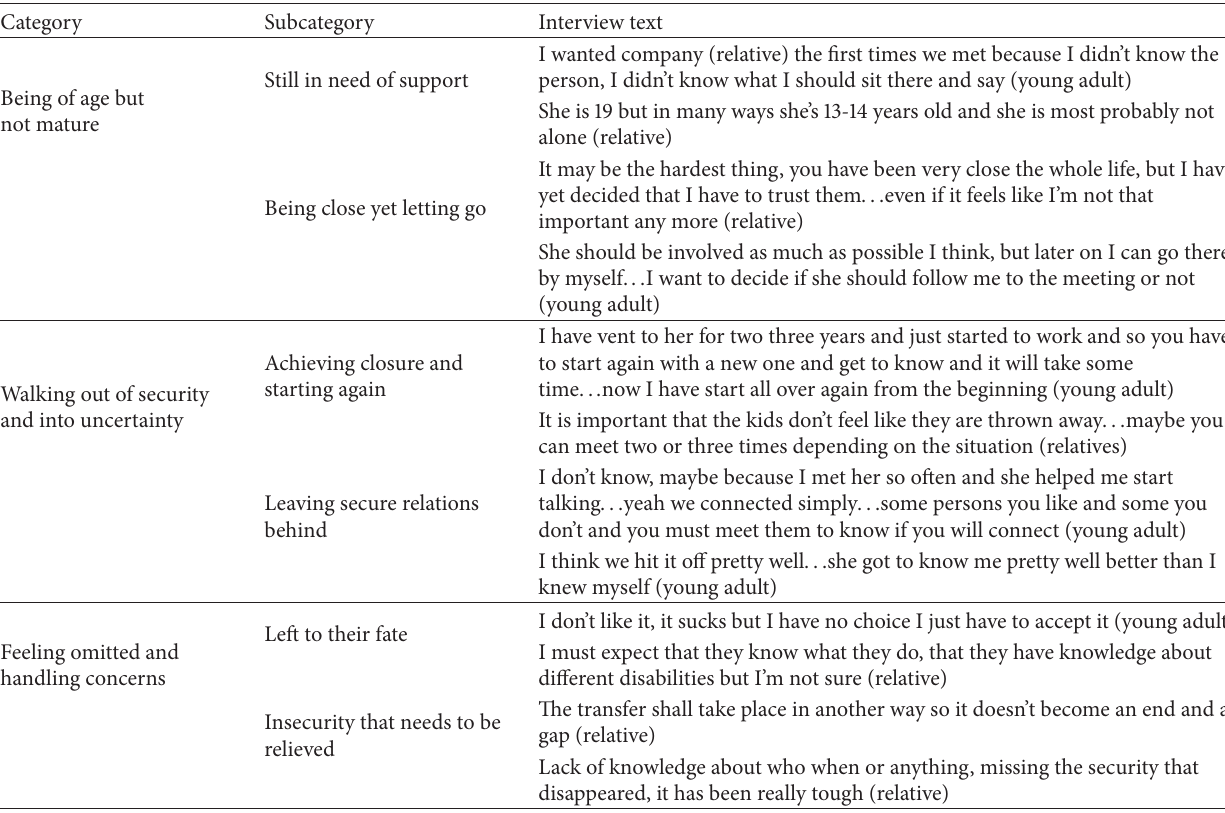
Table 1: Overview of the analysis process.